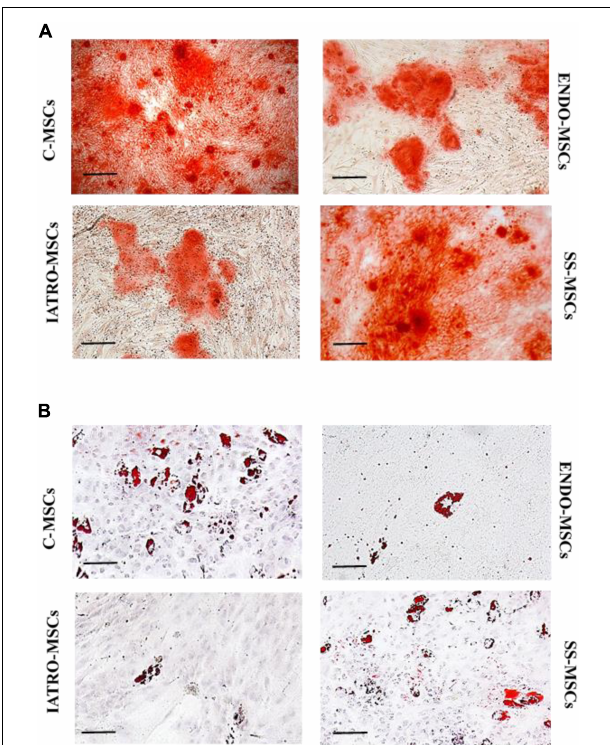
FIGURE 2 | Multilineage differentiation of MSCs. Representative images of differentiation experiments. (A) Osteogenic differentiation after staining with Alizarin Red. (B) Adipogenic differentiation by Oil Red staining. Scale bar = 100 µ